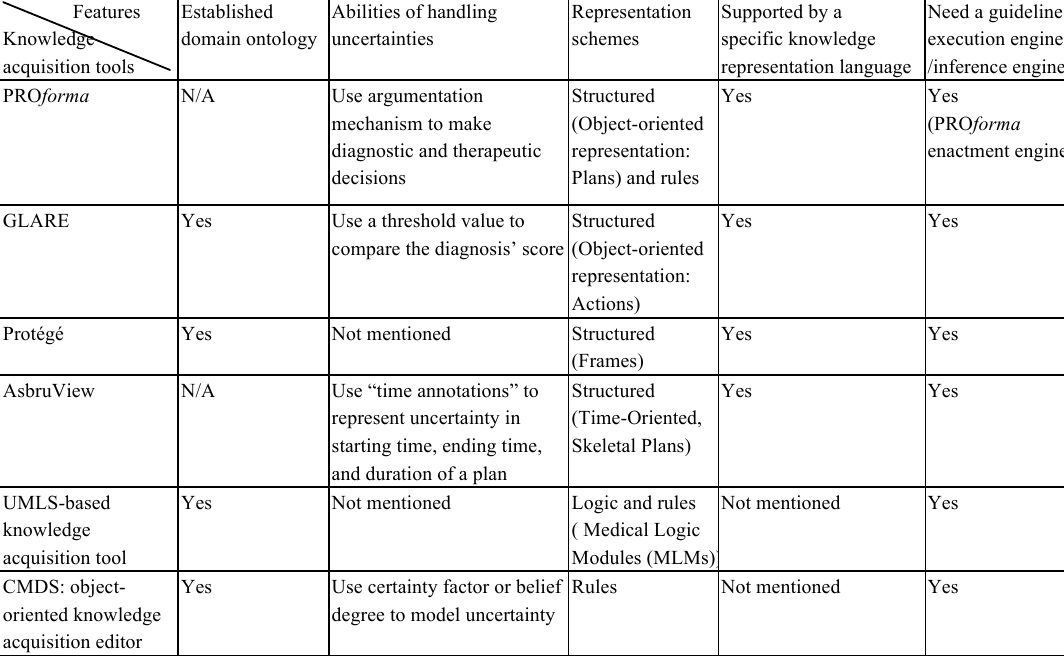
Table 3.1 Knowledge Acquisition Tools